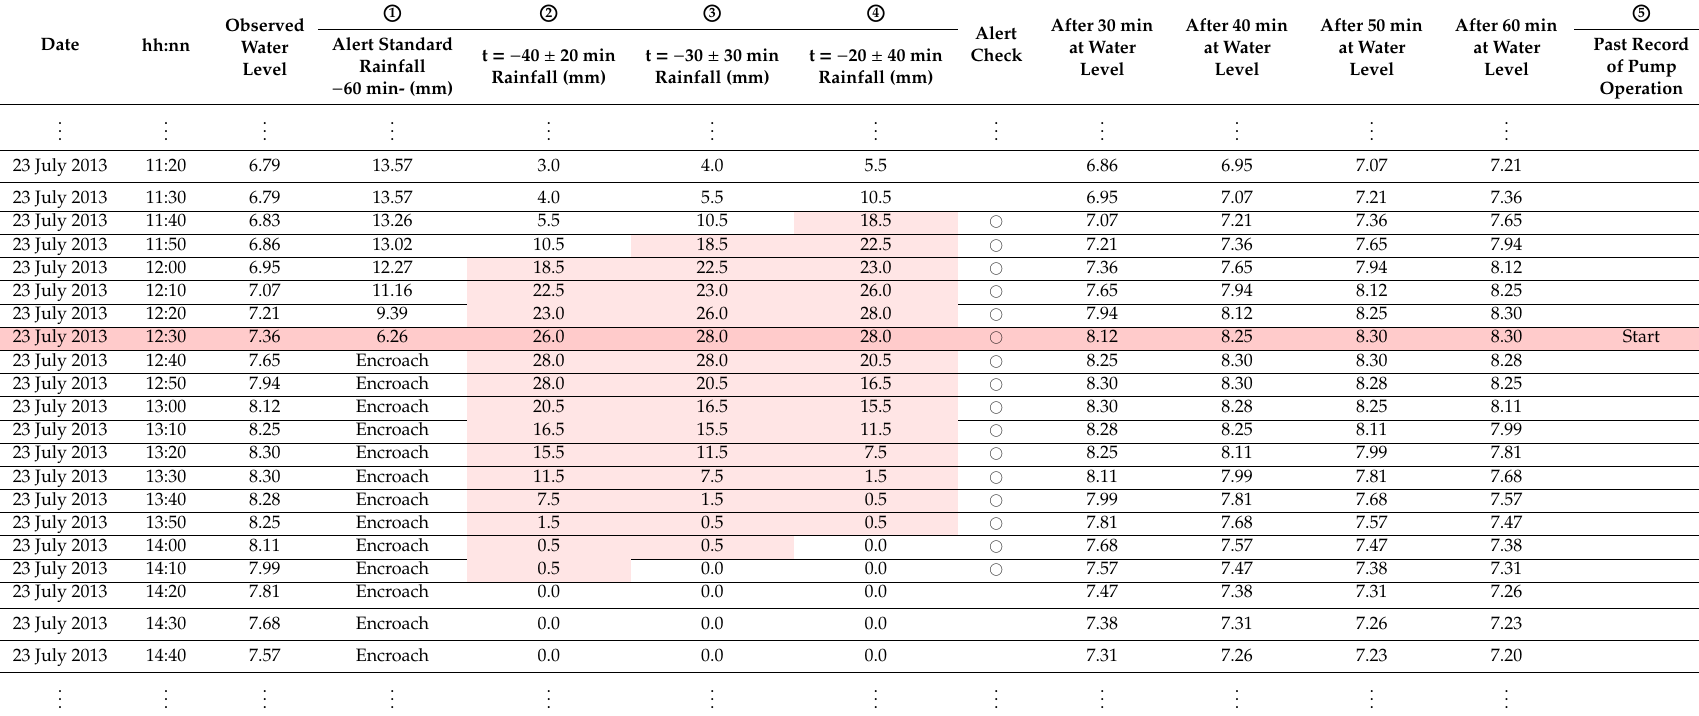
Table 10. Comparison of real-time water level observations in Dorim Stream (23 July